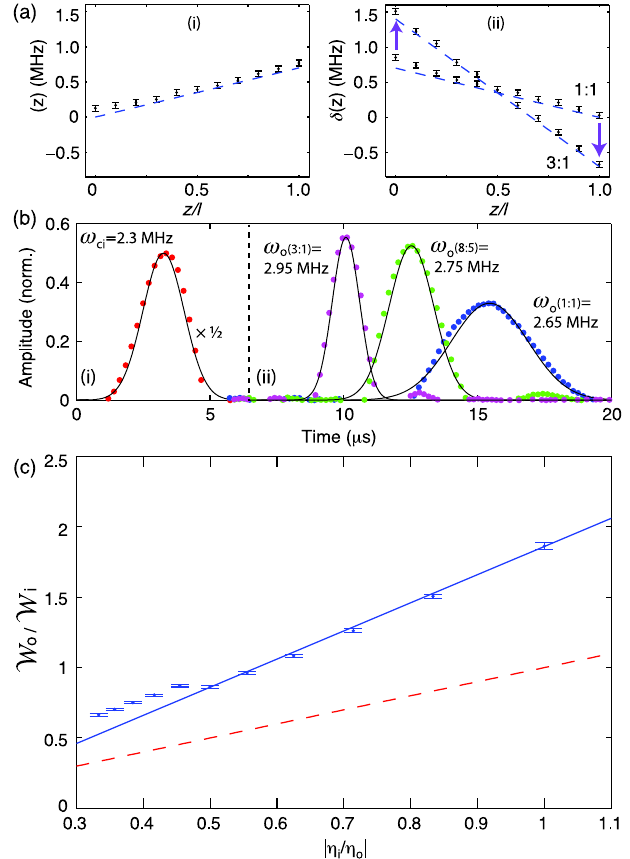
FIG. 4. Manipulating pulse bandwidth. (a) Two-photon detun- ing (cid:5) as a function of position z along the memory (normalized to length l ) due to (i) the input gradient and (ii) minimum and maximum output gradients (ratios noted on figure). The blue (dashed) line corresponds to the desired field, and points corre- spond to the measured magnetic field. (Error bars are due to the sensitivity of the Gauss meter.) (b) Amplitude plot, normalized to the size of the input pulse, showing (i) the input pulse (in red, scaled by a factor of 1 = 2 ) and (ii) output pulses recalled with varying output gradients as noted. Points correspond to demodu- values lated data, lines correspond to Gaussian fit to data, and ! c correspond to the center frequencies of pulses relative to the LO. =(cid:1) . (c) The FWHM of the The bracketed ratios indicate (cid:1) o i normalized to the FWHM of the input pulse output pulses W o j . W =(cid:1) , as a function of input gradient over output gradient j (cid:1) i i o Points represent measured FWHM (error bars are from standard deviation of 100 traces), the red (dashed) line corresponds to Eq. (3), and the blue (solid) line corresponds to a numerical simulation, with free parameters: g ¼ 0 : 066 s (cid:2) 1 , (cid:3) 0 ¼ 0 , and gN=c ¼ 1000